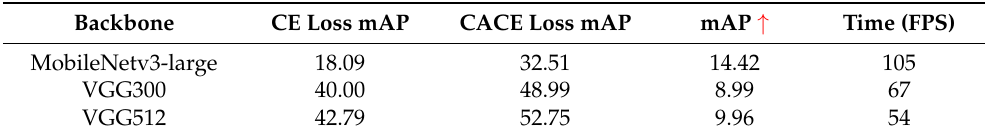
Table 1. Experimental result (mAP %) of 82 species on the SEAMAPD21 dataset, where CE stands for cross-entropy loss and CACE stands for class-aware cross-entropy loss; ↑ means increment. VGG300 is the VGG16 backbone with an image size of 300 × 300, and VGG512 is for an image size of 512 × 512. Backbone